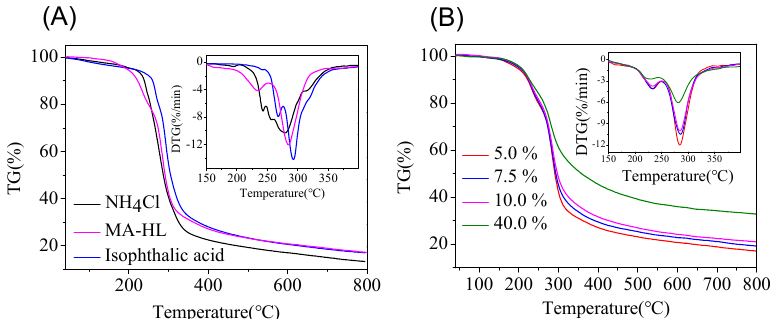
Figure 5. TG and DTG curves of ( A ) cured UF resins with di ff erent additives and ( B ) cured UF resins with di ff erent amounts of MA-HL.